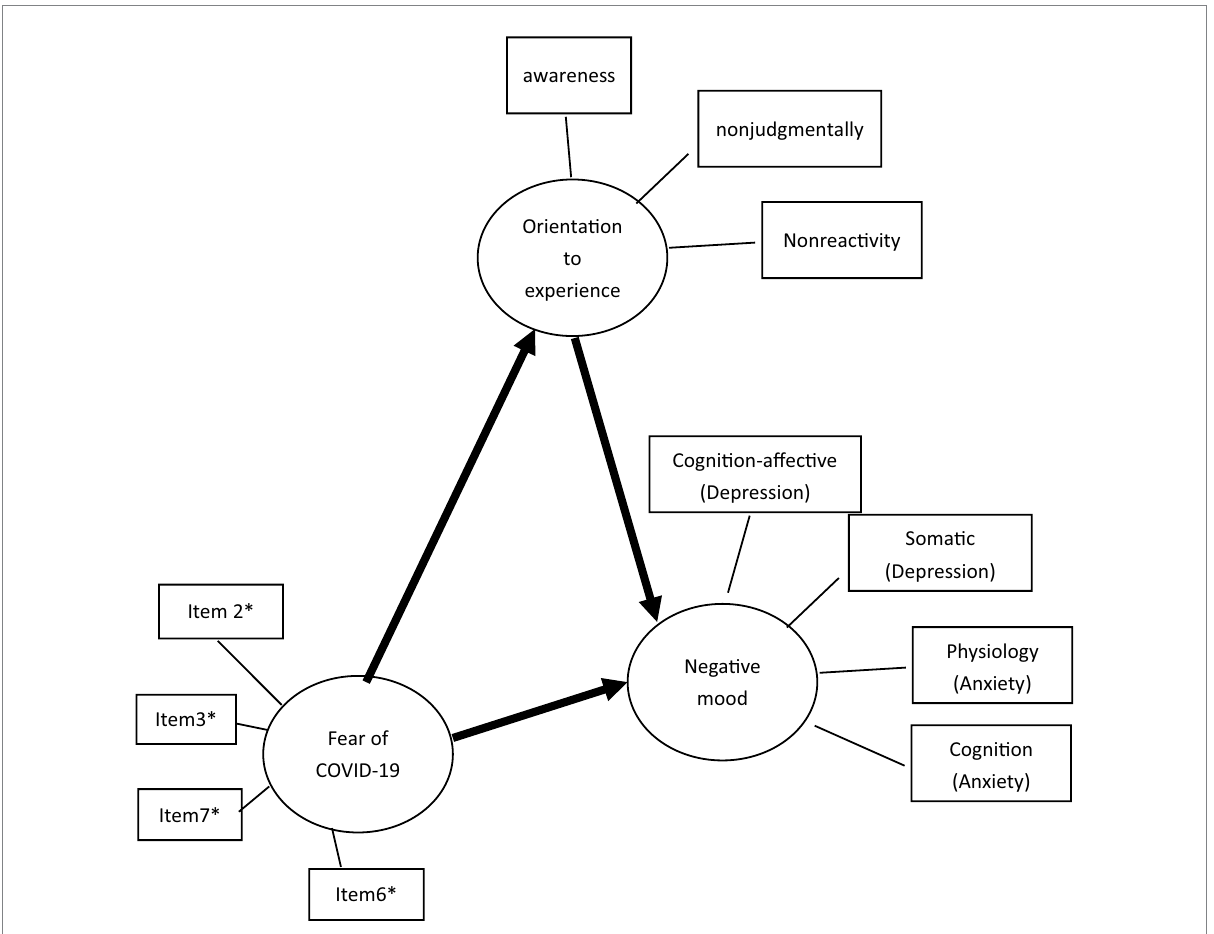
FIGURE 1 Hypothesized model. *Item 2: It makes me uncomfortable to think about coronavirus-19. *Item3: My hands become clammy when I think about coronavirus-19. *Item6: I cannot sleep because I’m worrying about getting coronavirus-19. *Item7: My heart races or palpitates when I think about getting